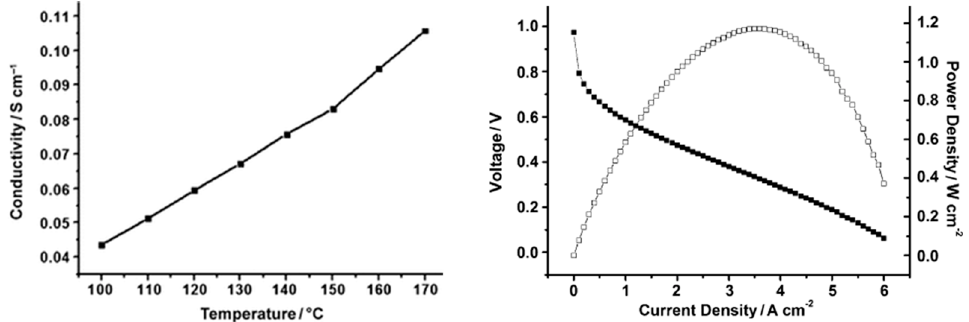
Figure 10. Variation of conductivity of PA doped OPBI with temperature ( left ) and fuel cell performance ( ▪ : voltage, □ : power density) of the OPBI membrane ( right ). Reproduced from [83] with permission of John Wiley and Sons.